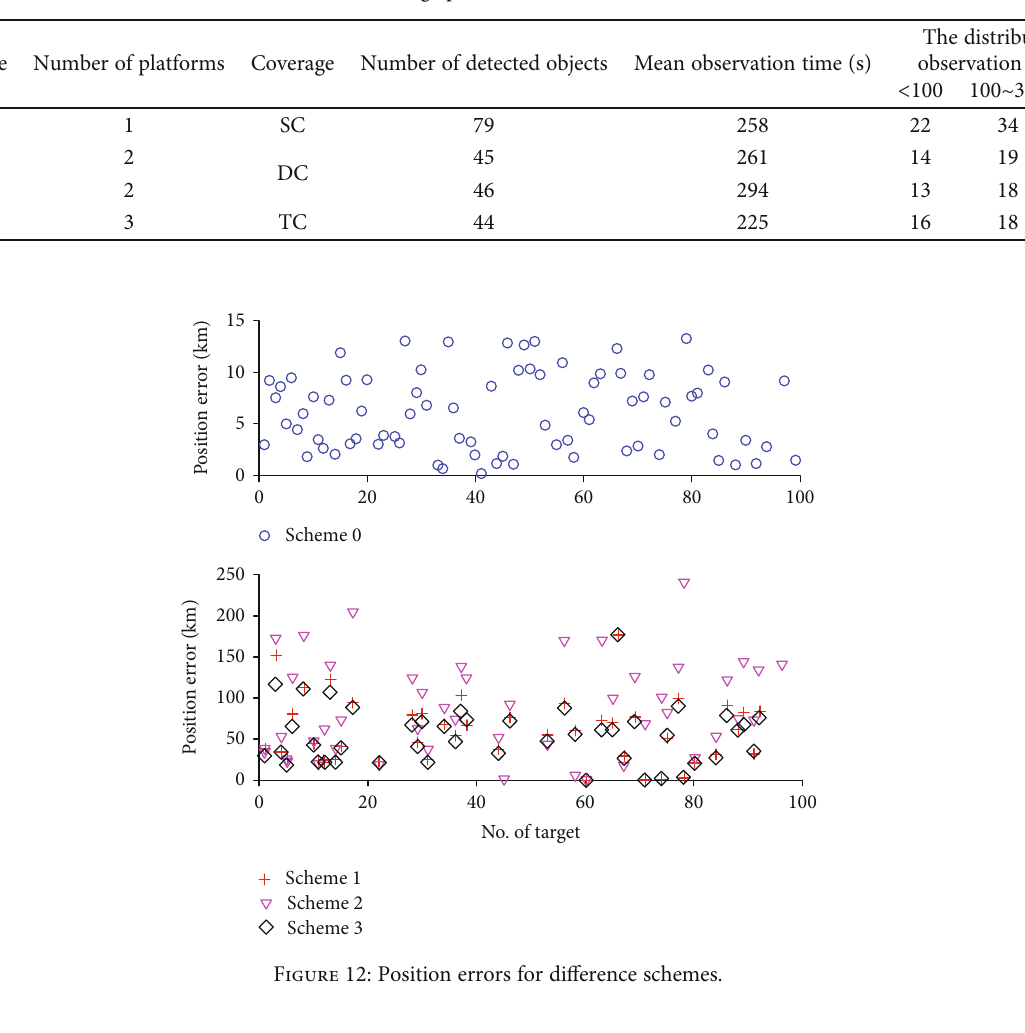
Table 9: The coverage performances of di ff erent schemes.